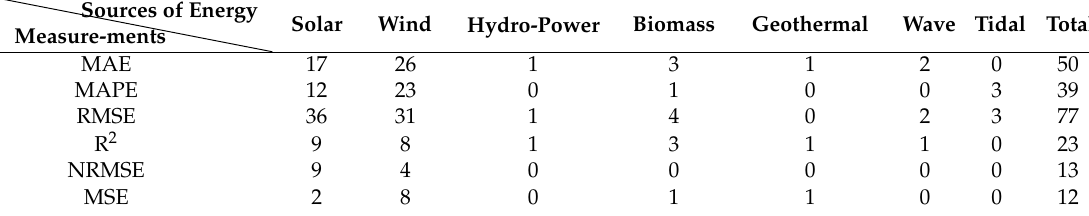
Table 6. Measurements of forecasting accuracy used by more than 10 studies.